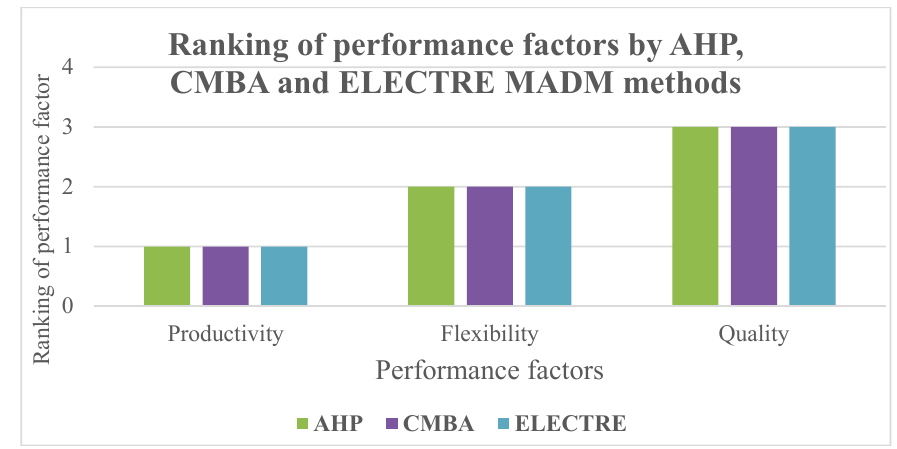
Fig. 5. Ranking of performance factors